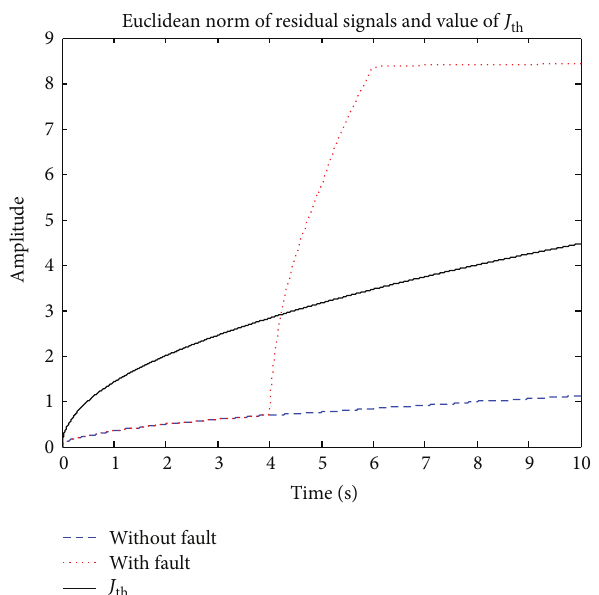
Figure 4: Detecting occurrence of fault using RMS norm of ‖𝑟(𝑡)‖ 𝑇 2 .